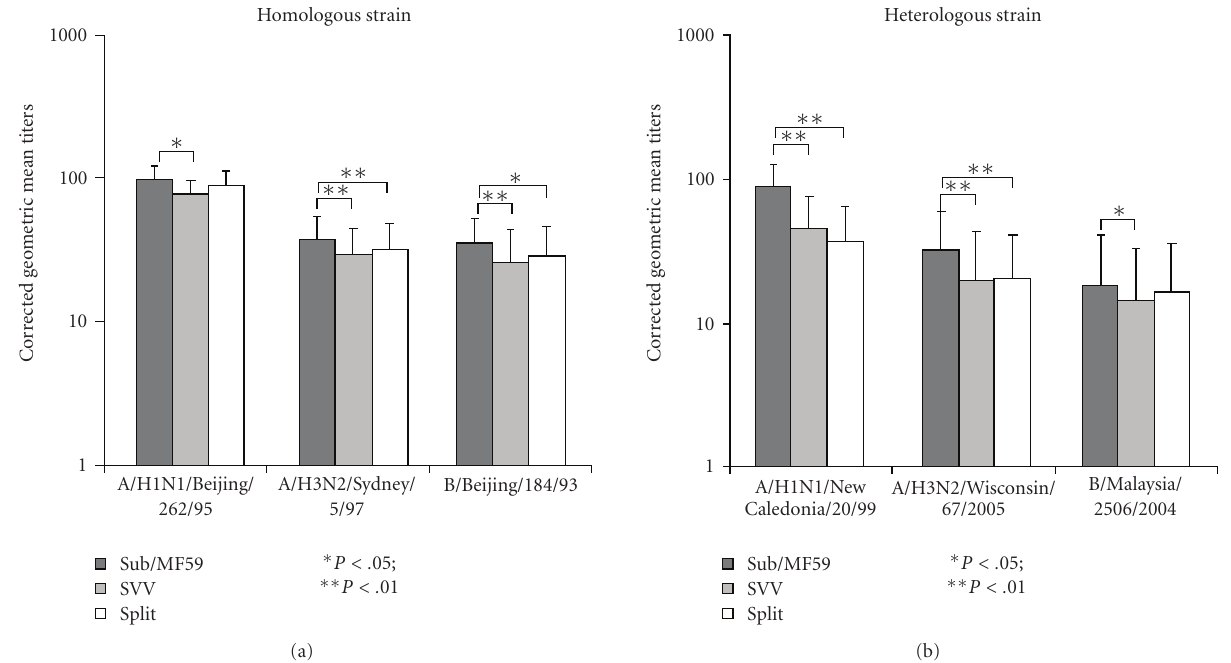
Figure 2: GMTs against homologous and heterologous influenza strains, according to vaccine